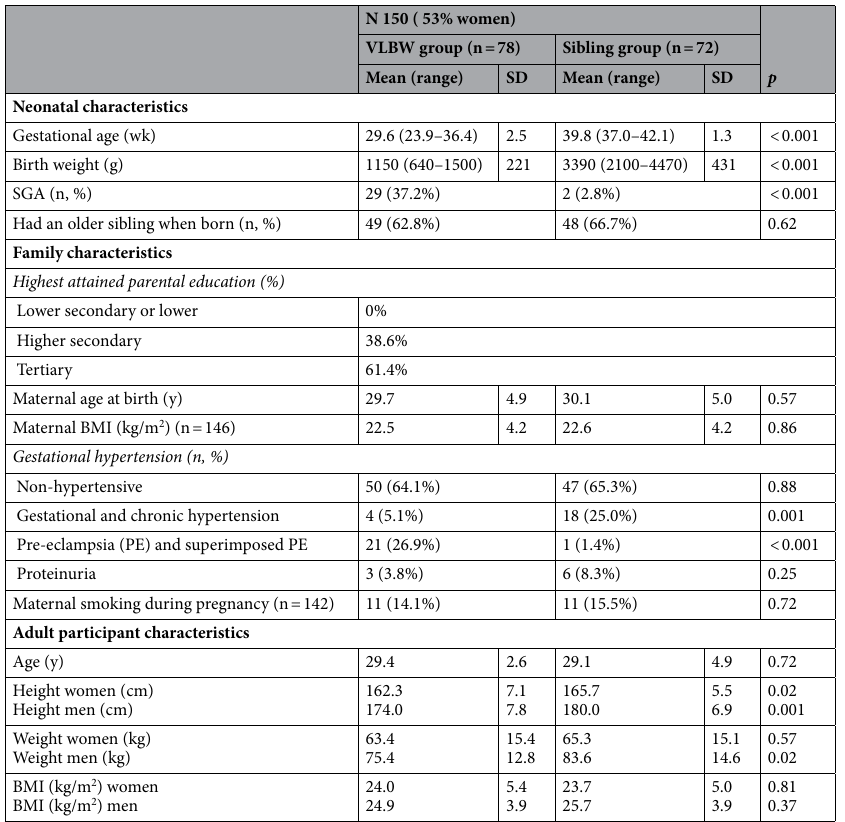
Table 1. Demographic and anthropometric characteristics of VLBW subjects and their term siblings. VLBW: very low birth weight (< 1500 g). SGA: small for gestational age (< − 2 SD). BMI: body mass